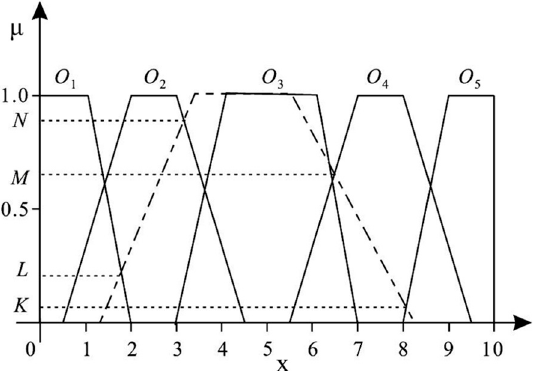
Figure 4. Schematic diagram of level evaluation of failure occurrence.